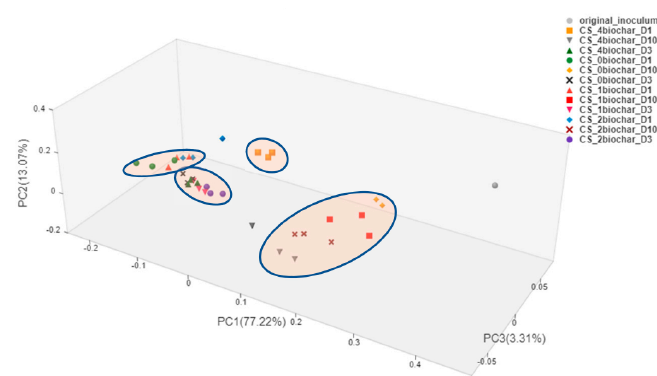
Figure 4. 3D-Principal coordinates analysis (PCoA) biplots of Bray-Curtis distances of bacteria during